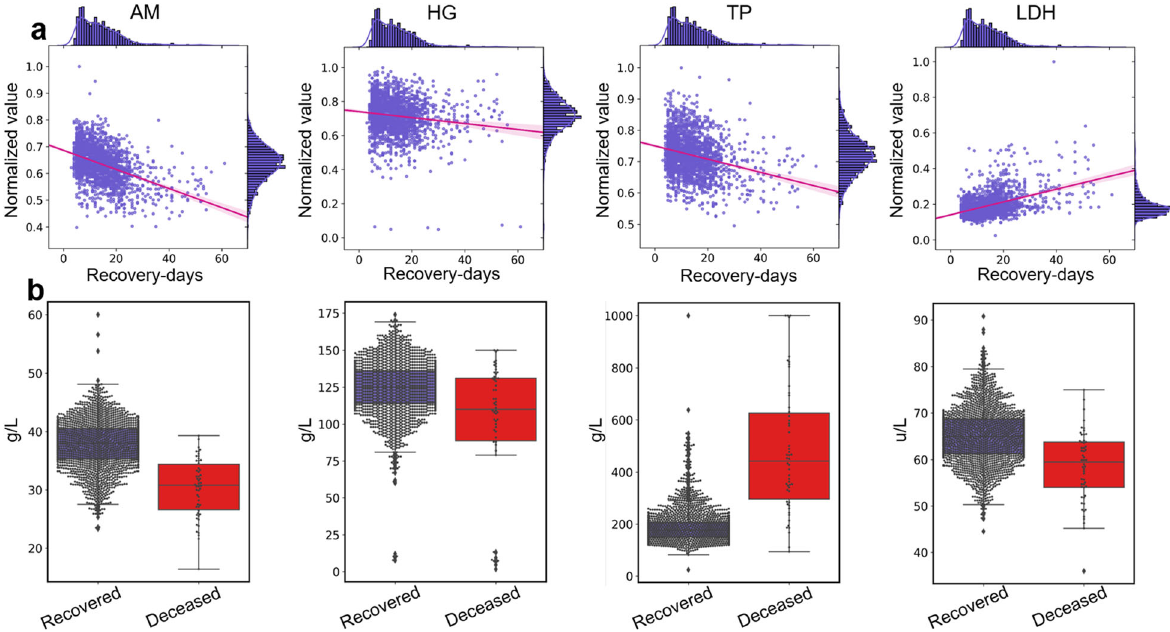
Fig. 6 Value distribution of the main biomarkers among all recovered and deceased patients. a Plots of the distribution of AM (albumin), HG (hemoglobin), TP (total protein), and LDH (lactate dehydrogenase) in recovered patients, demonstrating that the recovery day is statistically negatively correlated with AM , HG , and TP but positively correlated with LDH (see the red lines, p value<0.001 with a Pearson correlation analysis). b The difference in the AM , HG , TP , and LDH statistics between the recovered and deceased patients. Compared with the recovered patients, the patients who died generally had lower levels of AM , HG , and LDH and higher levels of TP . The centerline and the bounds of each box correspond to the median value and the interquartile range, respectively, and the whiskers mark the range of the non-outlier